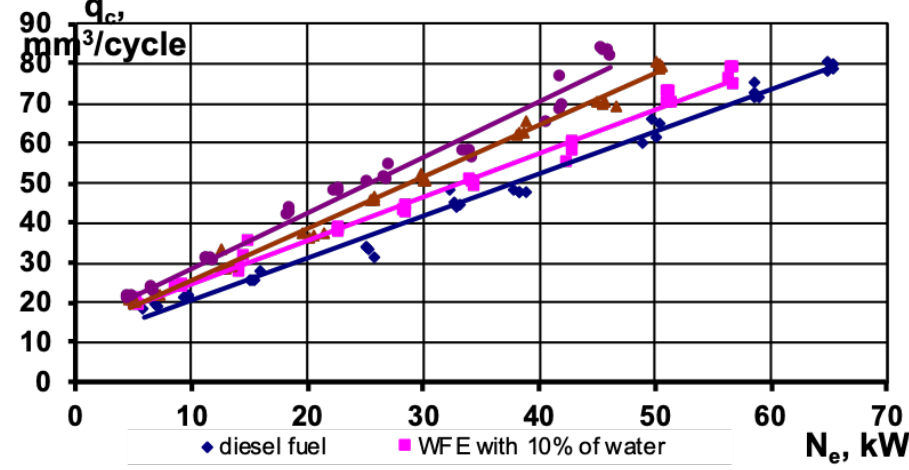
Figure 3. Cycle fuel rate (q c ) at the engine load characteristic when working on diesel fuel and water–fuel emulsions with water contents of 10%, 20%, and 30% by weight at an engine speed of 1700 rpm.